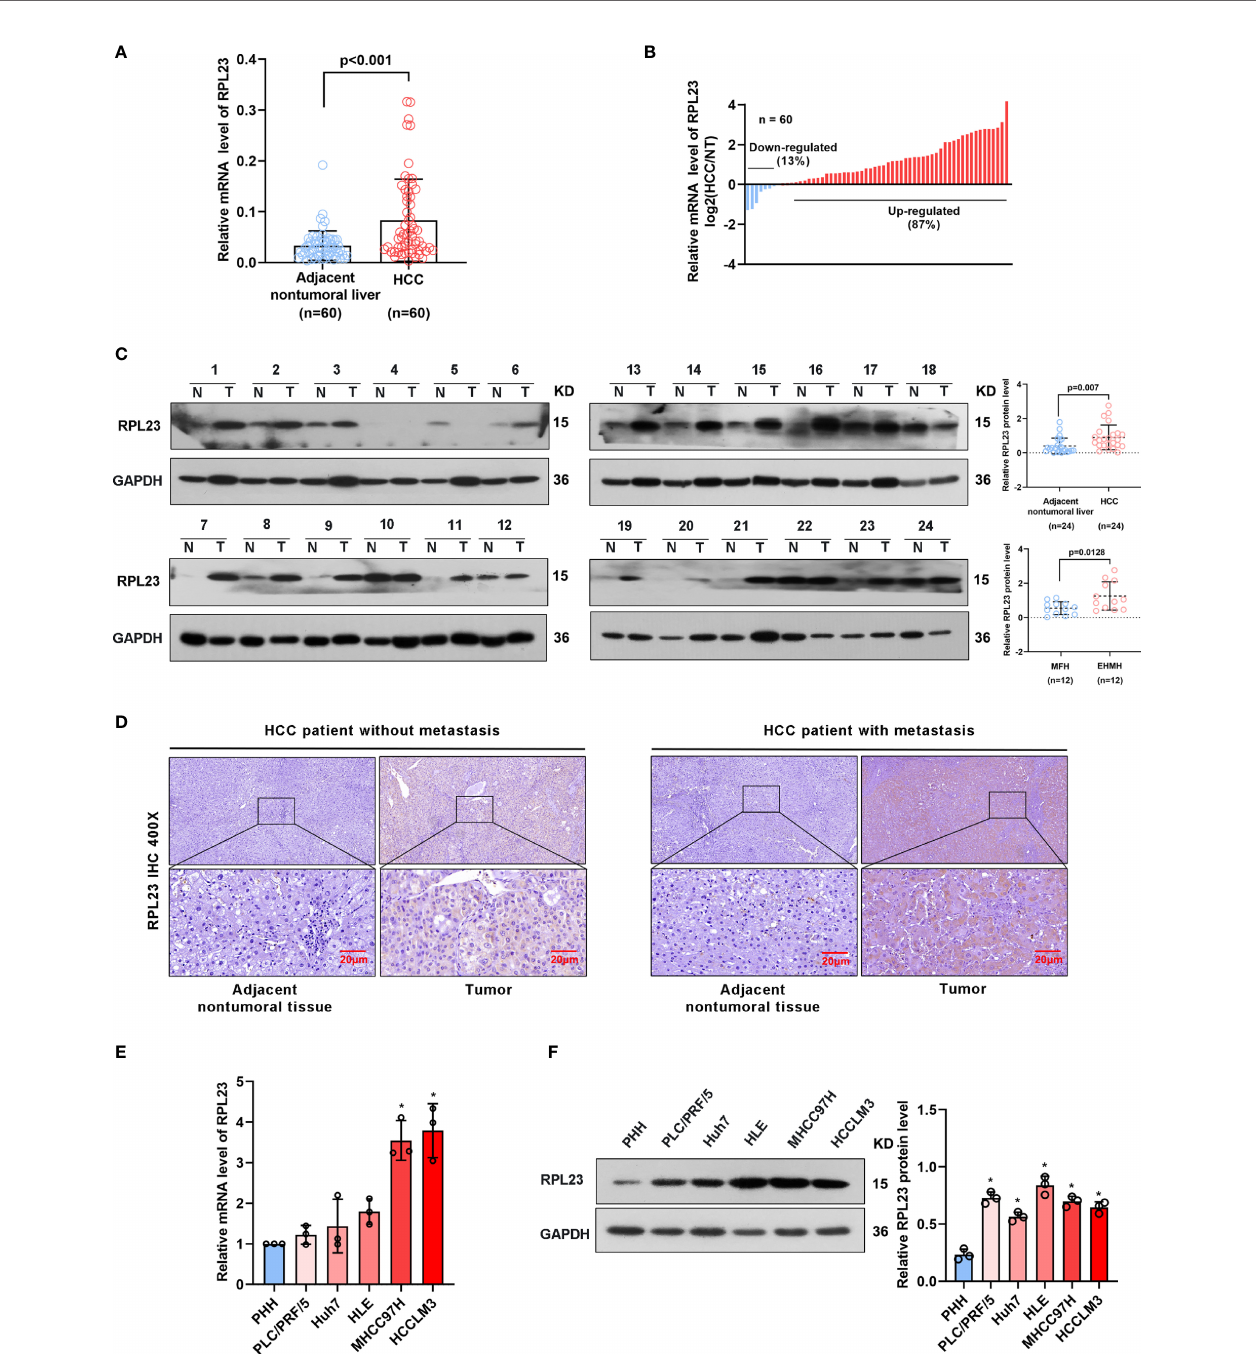
FIGURE 2 | RPL23 levels increased in HCC tissues and overexpressed in different HCC cell lines. (A) The mRNA level of RPL23 in liver cancer was elevated in 60 paired samples of HCC tumor tissues with extrahepatic metastasis (EHMH) and metastasis-free HCC tissues (MFH), as determined by qRT-PCR analyses. (B) RPL23 mRNA levels in 60 HCC and paired non-tumor tissues. (C) RPL23 protein level in 24 paired primary HCC tissues with extrahepatic metastasis (EHMH) and metastasis-free HCC tissues (MFH) was detected by western blotting. GAPDH was used as loading control. (D) Representative immunohistochemical images of RPL23 staining in the paired HCC specimens with or without metastasis. (magni fi cation, 400×) (E, F) qRT-PCR and Western blotting analyses of RPL23 expression in primary human hepatocytes and different HCC cell lines. GAP DH was used as loading control. Representative data are from at least three independent experiments. Data are shown as mean ± SD. *P <